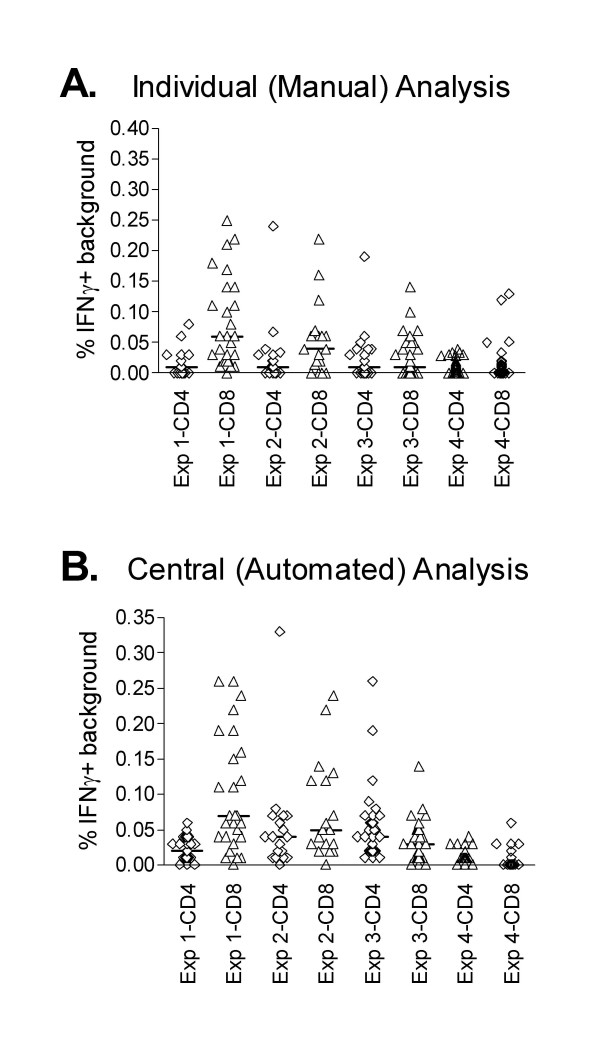
Background cytokine-producing cells by experiment. Cytokine-positive cells in the absence of stimulus are expressed as a percentage of CD4+ or CD8+ T cells. Each symbol represents the background from a single sample processed by a single site. Medians are shown by a horizontal bar. Data from experiment 4 are for cocktails 2 and 3 only, to be comparable with experiments 1–3.